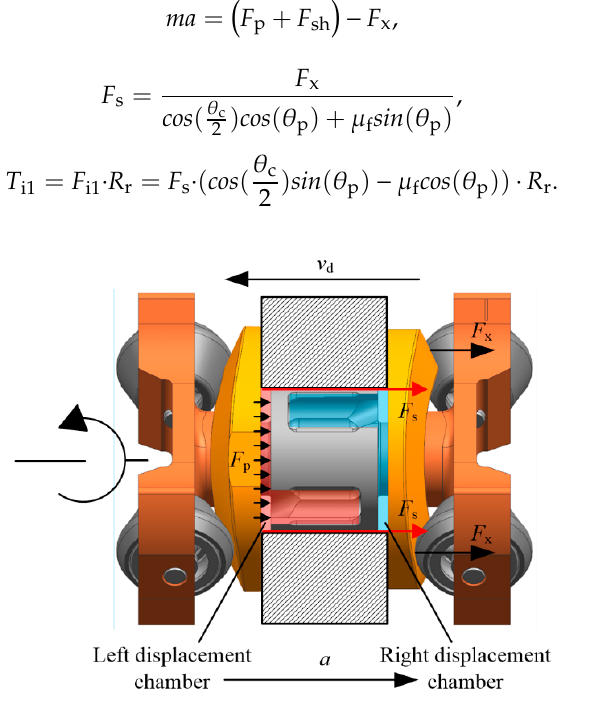
Figure 8. Force analysis of the driving set while rotating from 45 degrees to 90 degrees when the load pressure is low.